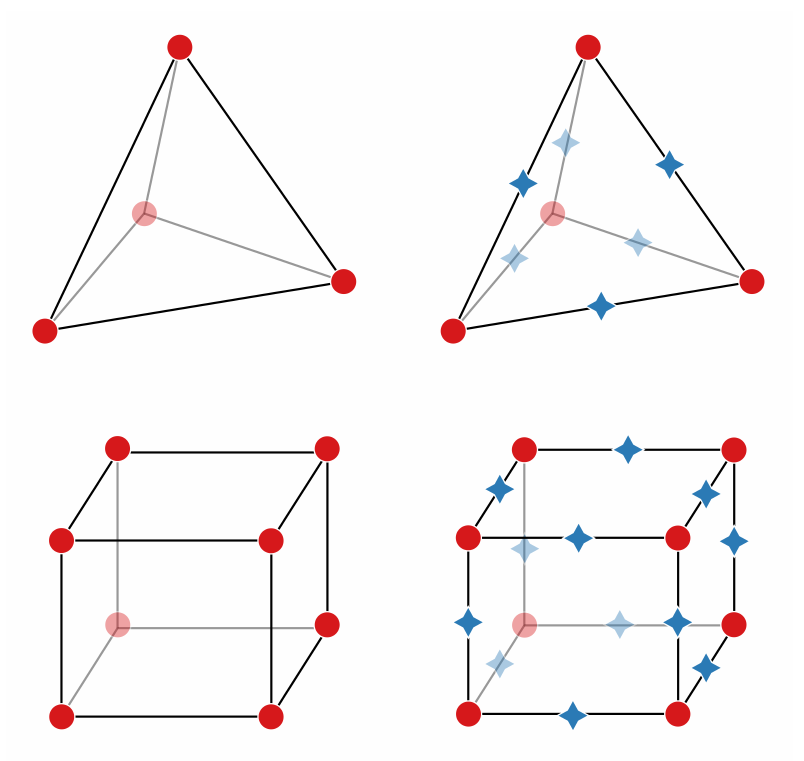
Figure 5. Currently available element types in the plugin. ( Top ): First and second order tetrahedron. ( Bottom ): First and second order